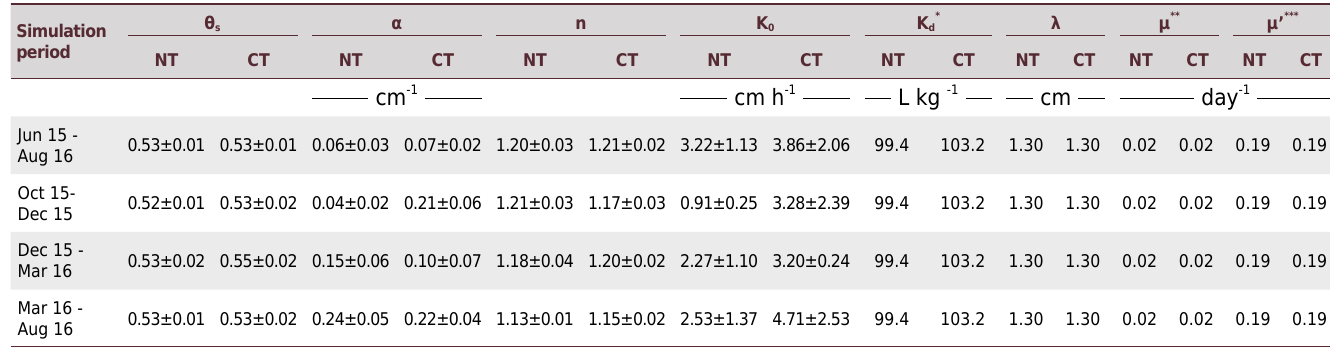
Table 1. Hydraulic (volumetric water content at saturation, θ s ; fitted van Genuchten parameters, α and n; saturated hydraulic conductivity, K 0 ) and transport (adsorption coefficient, K d ; soil dispersivity, λ; first-order rate constant for chain reaction, μ; first-order rate constant, μ’) parameters used in the different simulation periods for different treatments [No-tillage (NT) and Conventional tillage